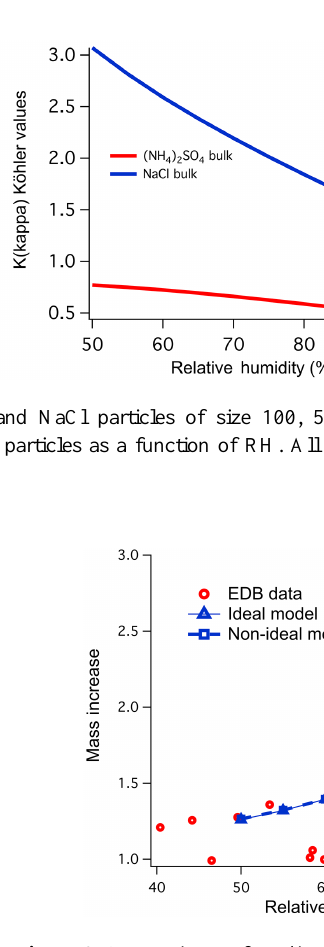
Figure 6. Comparisons of predicted water uptake, as particle mass increase (fraction), with EDB (electrodynamic balance) measure- ments on equimolar (NH 4 ) 2 SO 4 –glutaric acid